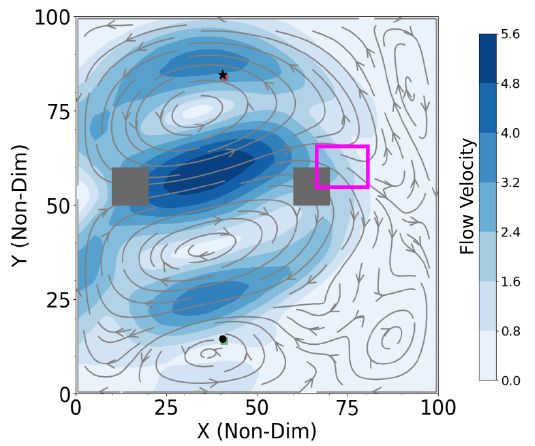
Figure A1. Another realization of the stochastic velocity field: The streamlines and background correspond to a different realization of the stochastic velocity